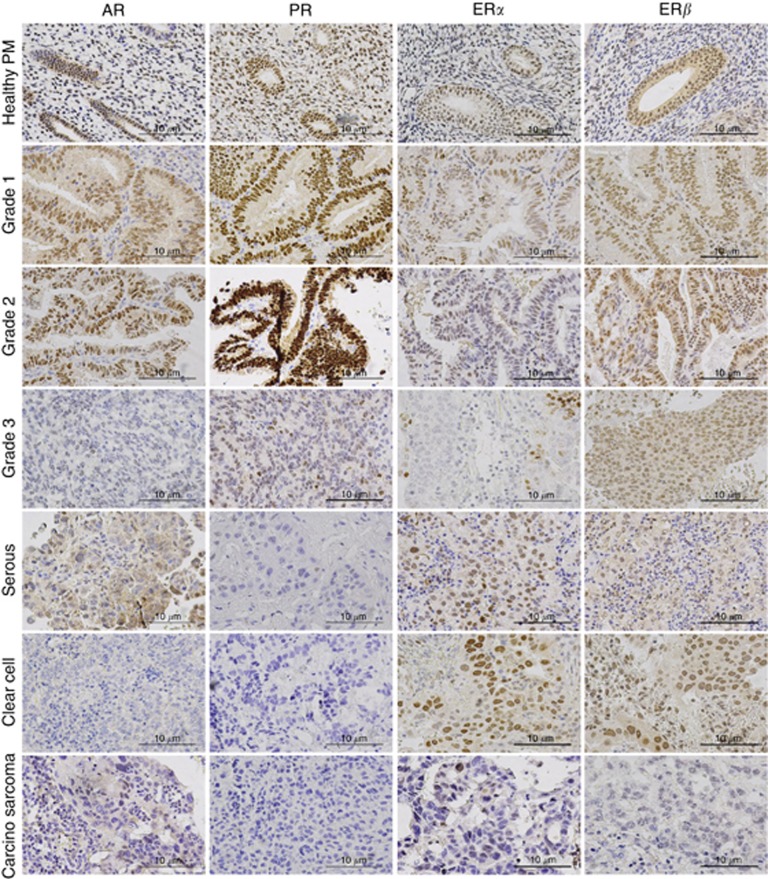
Representative photomicrographs of AR, PR, ERα and ERβ in human endometrium. Healthy PM endometrium, grade 1–3 endometrioid carcinoma, serous carcinoma, clear-cell carcinoma and carcinosarcoma were immunostained for AR, PR, ERα and ERβ. Positive staining appears brown. Magnification × 400.